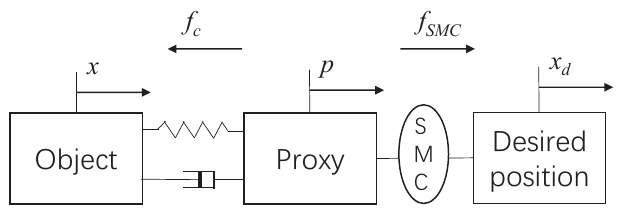
Figure 2. The physical interpretation of proposed